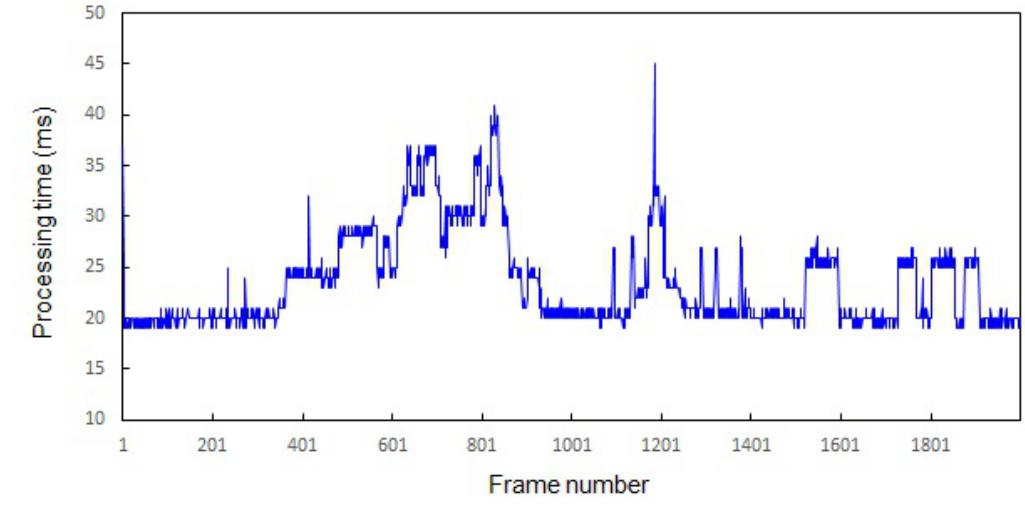
Figure 22. Processing time of the proposed